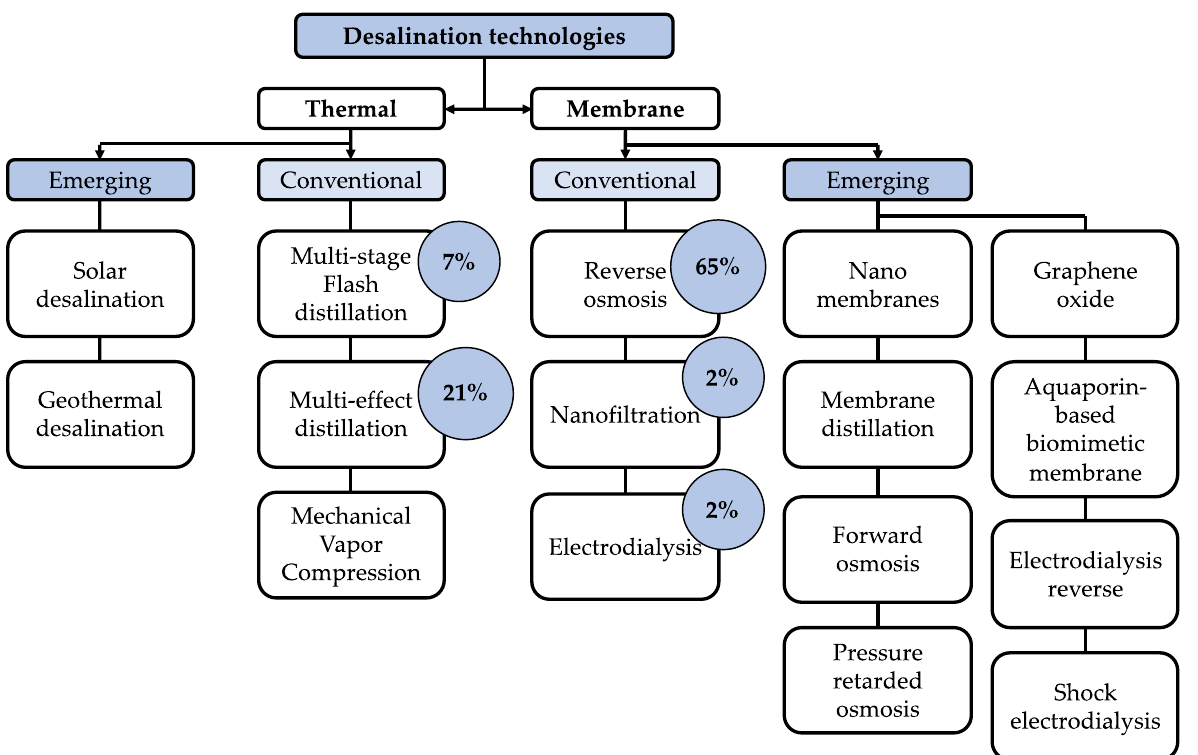
Figure 1. Schematic classification of desalination technologies.